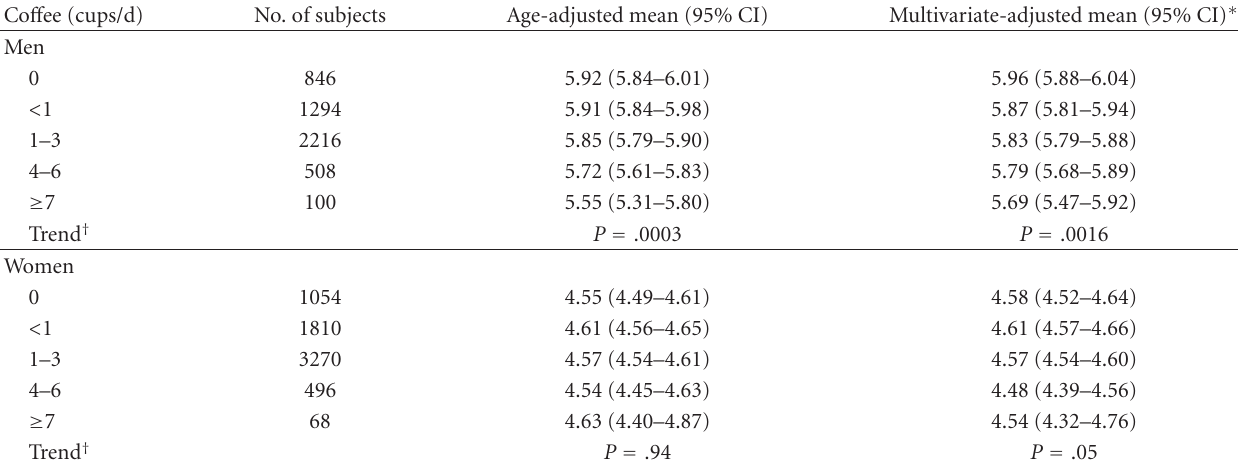
Table 3: Serum concentrations of uric acid according to co ff ee intake in men and women. Co ff ee